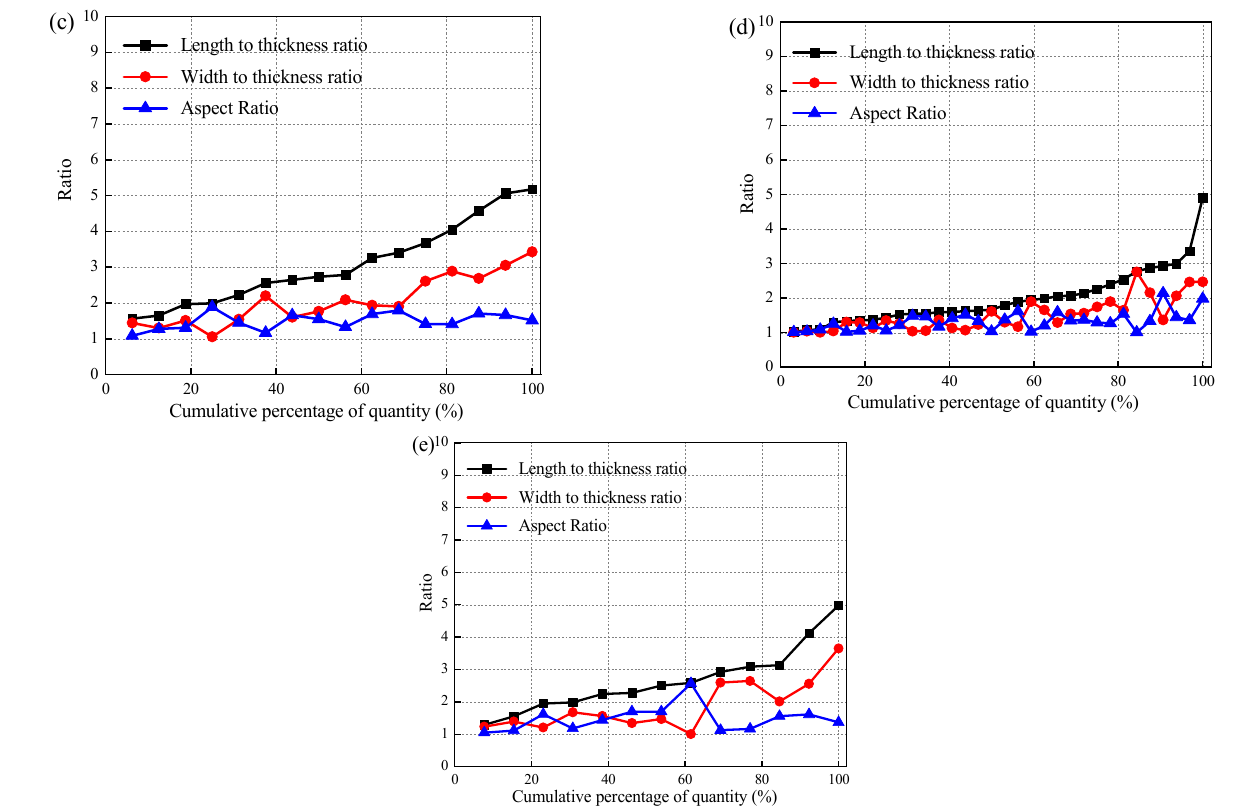
Figure 12. Debris scale ratio distribution of coal rock specimens with different laminar orientations. ( a ) θ = 0°, v = 3.221 m/s, ( b ) θ = 22.5°, v = 3.233 m/s, ( c ) θ = 45°, v = 3.308 m/s, ( d ) θ = 67.5°, v = 3.363 m/s, and ( e ) θ = 90°, v = 3.15 m/s.